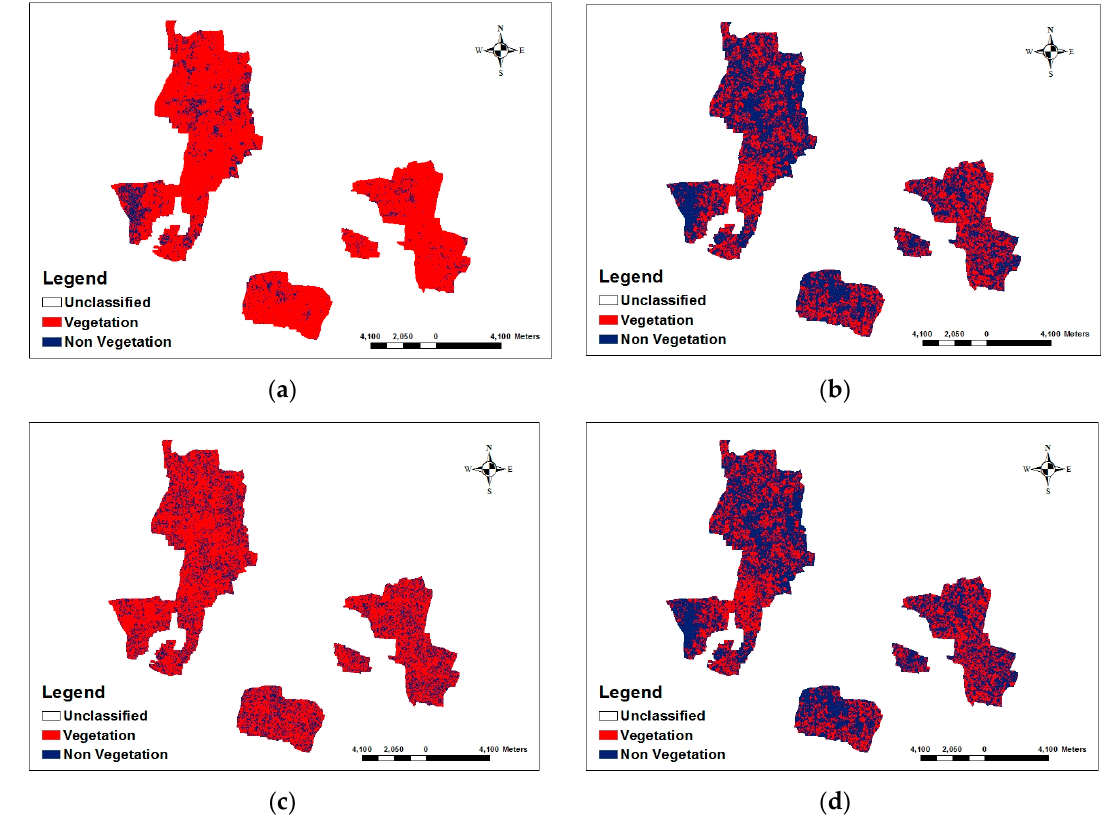
Figure 1. Vegetation based classified images for the year 2016: ( a ) Actual image; ( b ) Moving average forecasted image; ( c ) Exponential smoothing forecasted image; ( d ) Linear regression forecasted